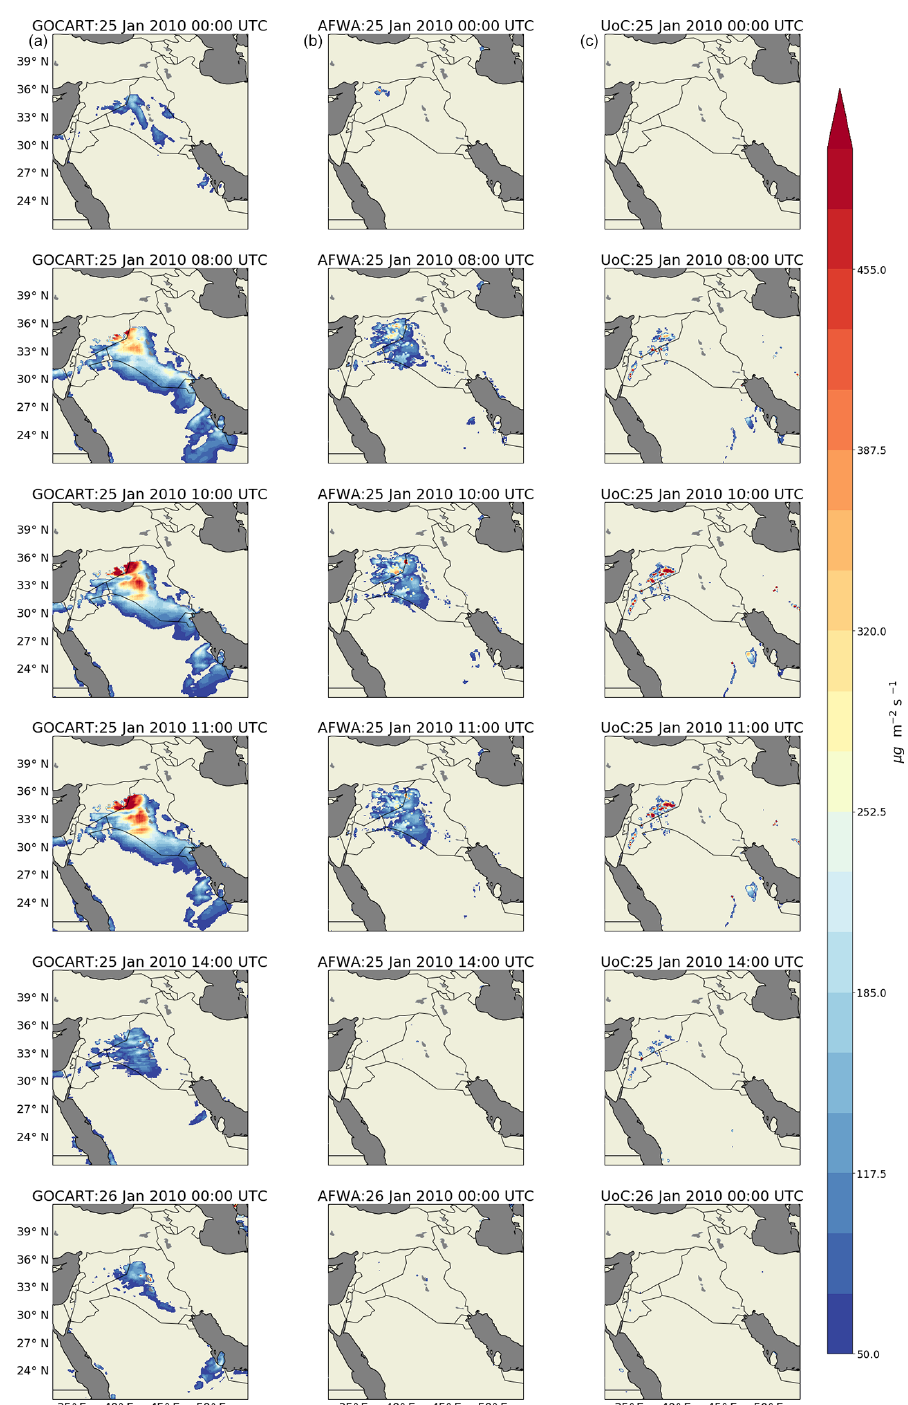
Figure 7. Modeled dust emissions from the GOCART-WRF (a) , AFWA (b) , and UoC (c) schemes with time advancing from top to bottom. Here, we provide simulation results for times that align with three CALIOP transect collections and three other times selected to show the evolution of the event. Emissions during the remainder of the time period represented in Figs. 5 and 6 are